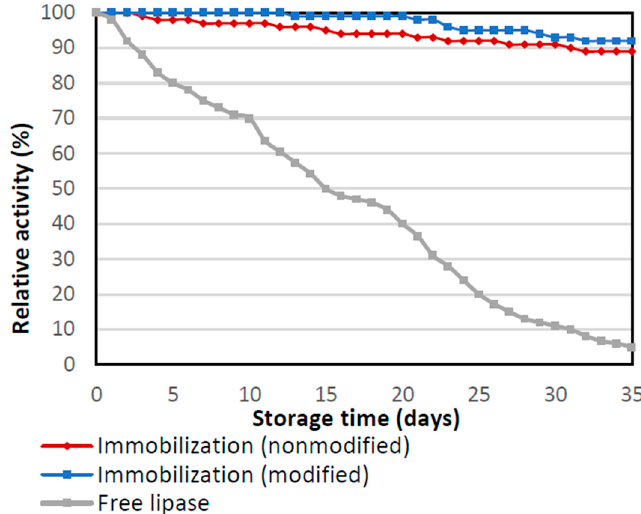
Figure 6. Storage stability of the native enzyme and lipase immobilized by physical immobilization by the adsorption interactions and partially interfacial activation (immobilization nonmodified) and mixed physical immobilization via interfacial activation and ion exchange (immobilization modified). All experiments were performed in duplicate and the results presented in each of the graphs are shown as a mean value, for which standard deviation (error value) does not exceed 5%.